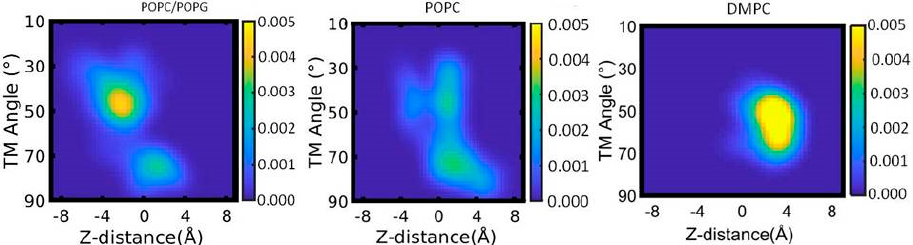
Figure 9. Probability density plot of transmembrane (TM) helical tilt angle against the Z-distance of TMD of KCNE3 in different lipid bilayer membranes. The yellow color indicates the highest probability, and the blue color represents the lowest probability.